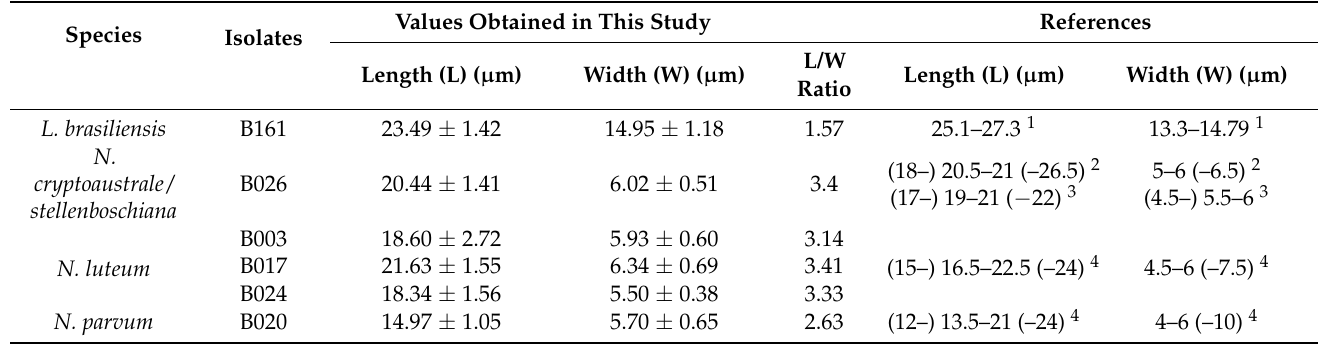
Table 4. Conidial dimensions of Lasiodiplodia and Neofusicoccum isolates from this study and compari- son with previous